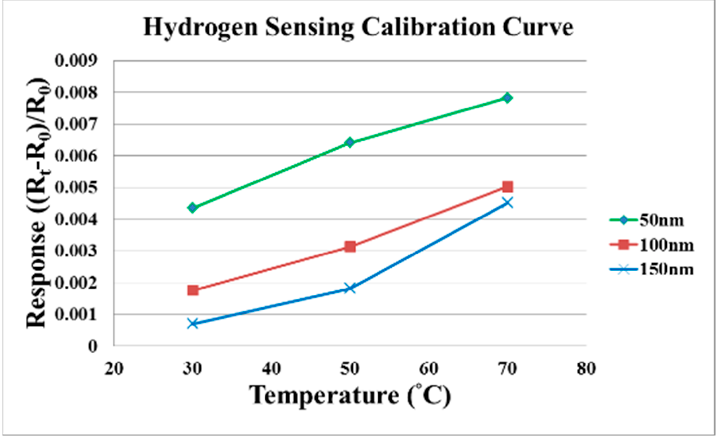
Figure 4. The film thickness of SnO 2 evaporated at different temperatures (50, 100, 150 nm) .